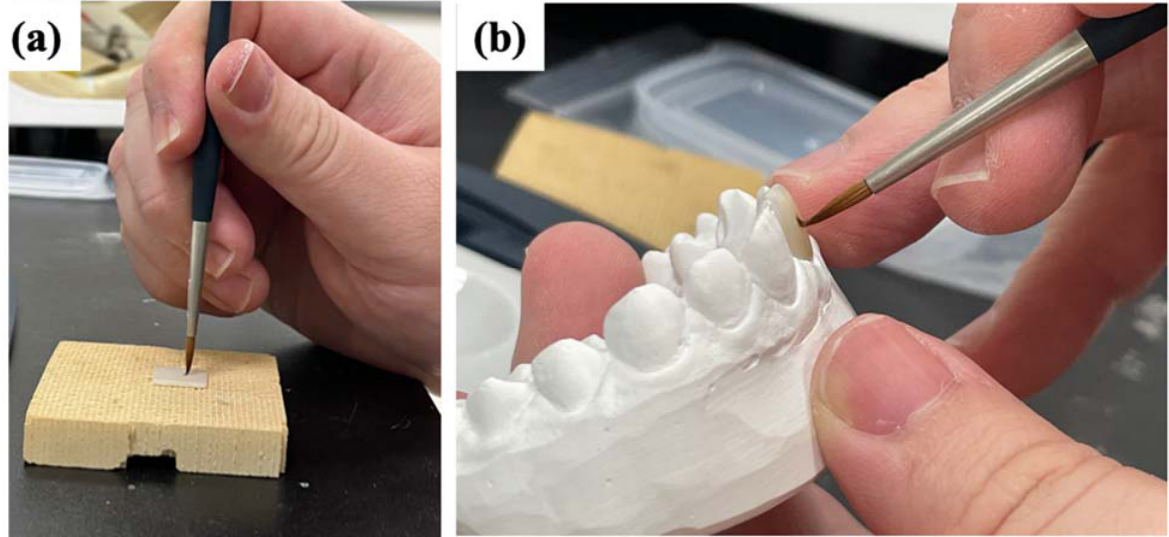
Figure 1. A dental technician performs zirconia surface staining: ( a ) piece and ( b ) crow.